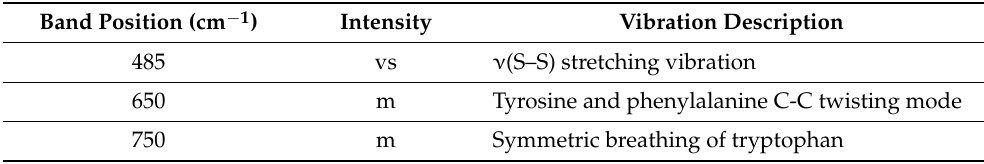
Figure 6. Raman vibrational bands observed in the manually obtained ESM (m: medium, s: strong, v: very, w: weak), band position assignments in Table 4. Table 4. Raman vibrational bands observed in the ESM (cm − 1 ; m medium, s strong, v very, w weak); table based on the assignments in [116 – 123].